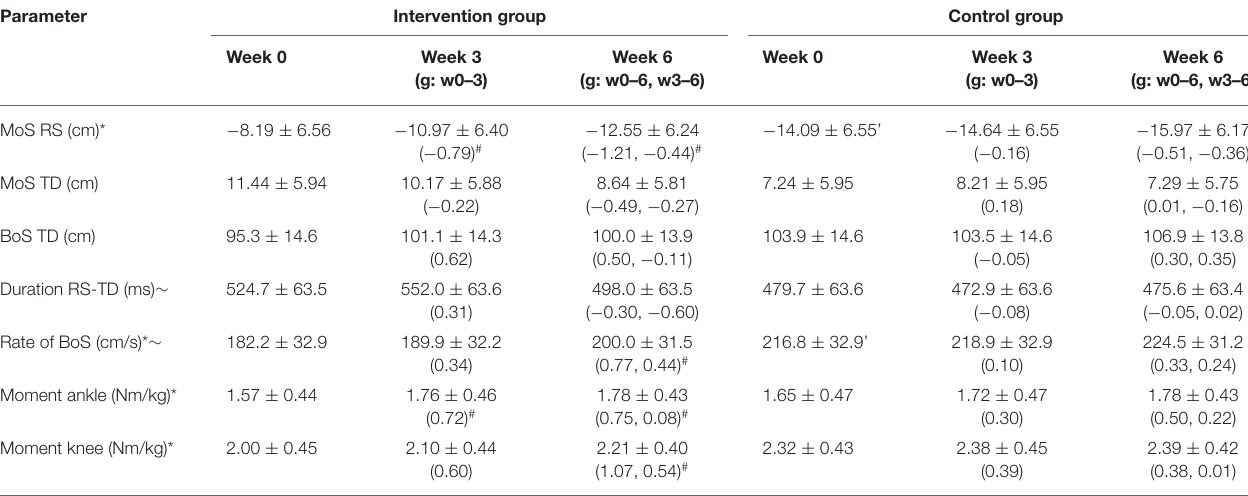
TABLE 1 | Outcome parameters before (week 0), within (week 3), and after (week 6) the training period for the intervention and control groups.